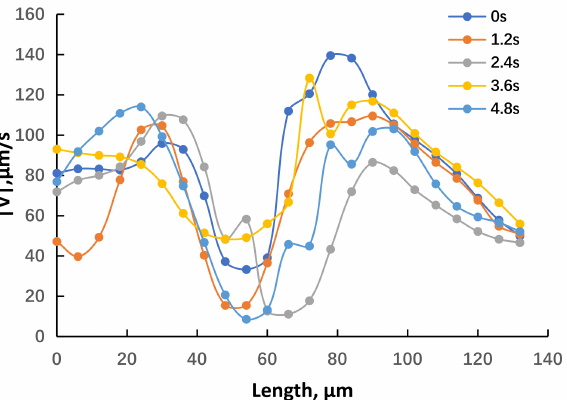
Figure 9. Velocity distribution along the flow through the throat at different time points in post-water flooding with